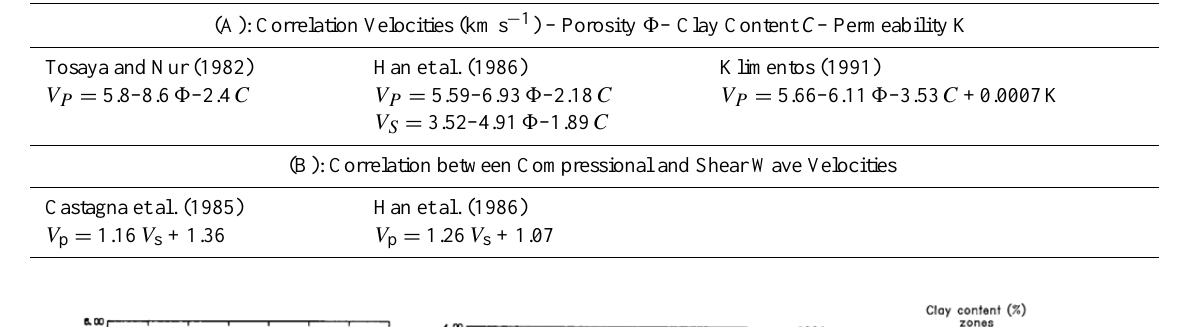
Table 2. Summary of some literature studies on correlations between seismic wave velocities ( V p – V s ) and their main influencing factors.